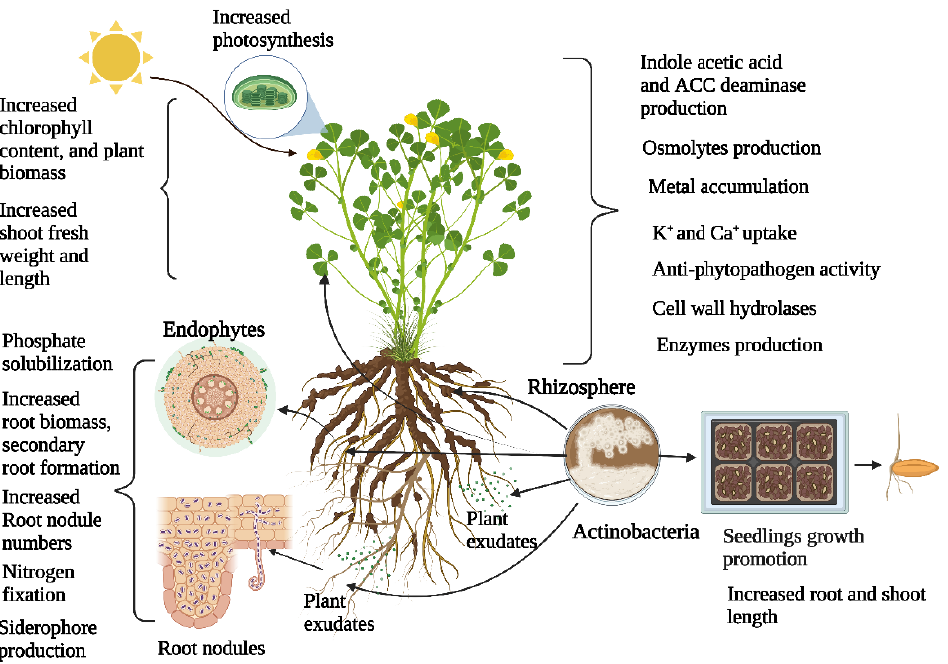
Figure 1. Role of Actinobacteria in various plant parts.